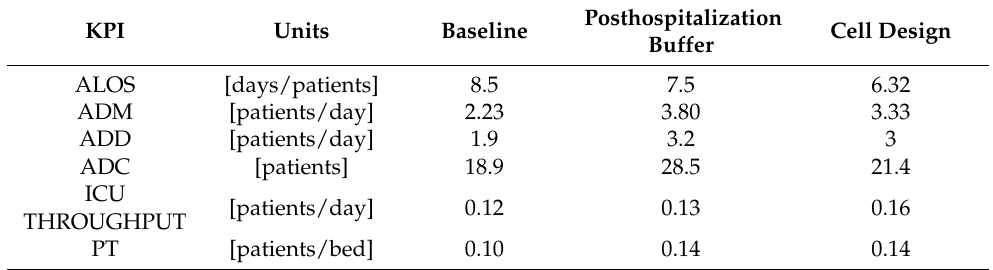
Table 4. KPIs for the three